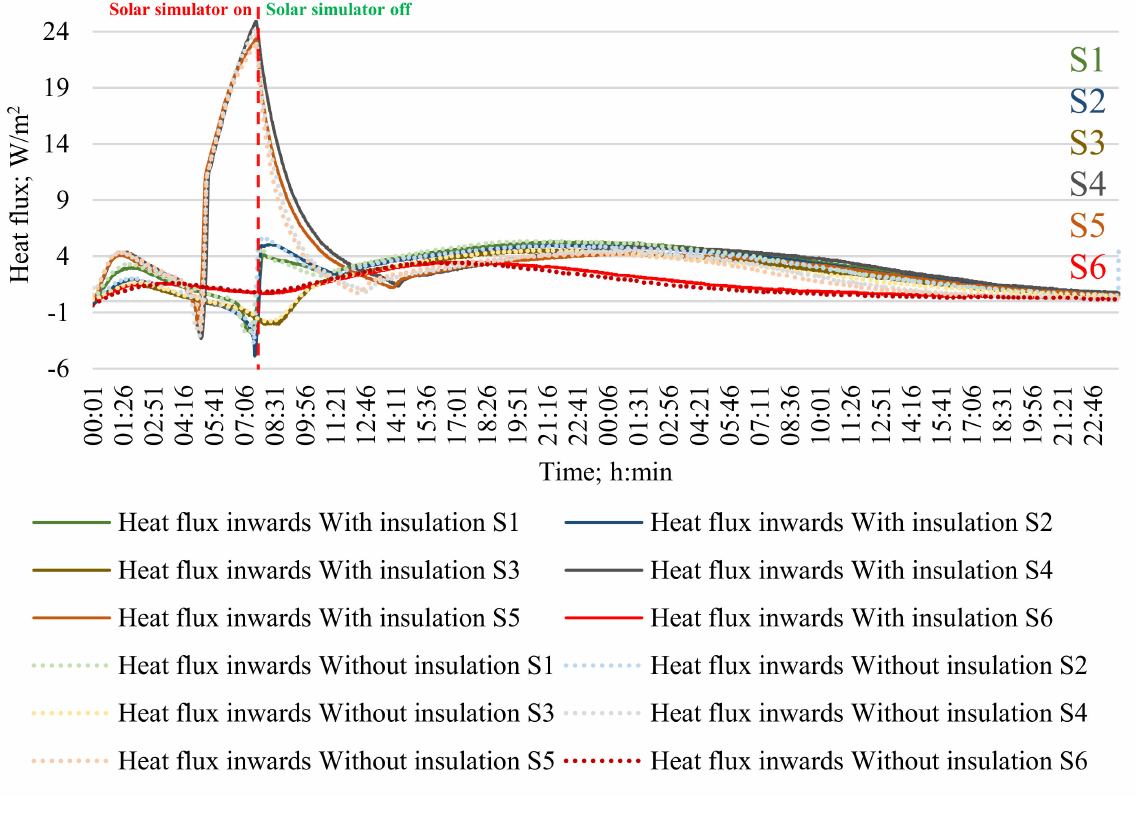
Figure 14. Inward heat flux comparison in all of the Setups with (W) and without (W/O) an adjustable insulation